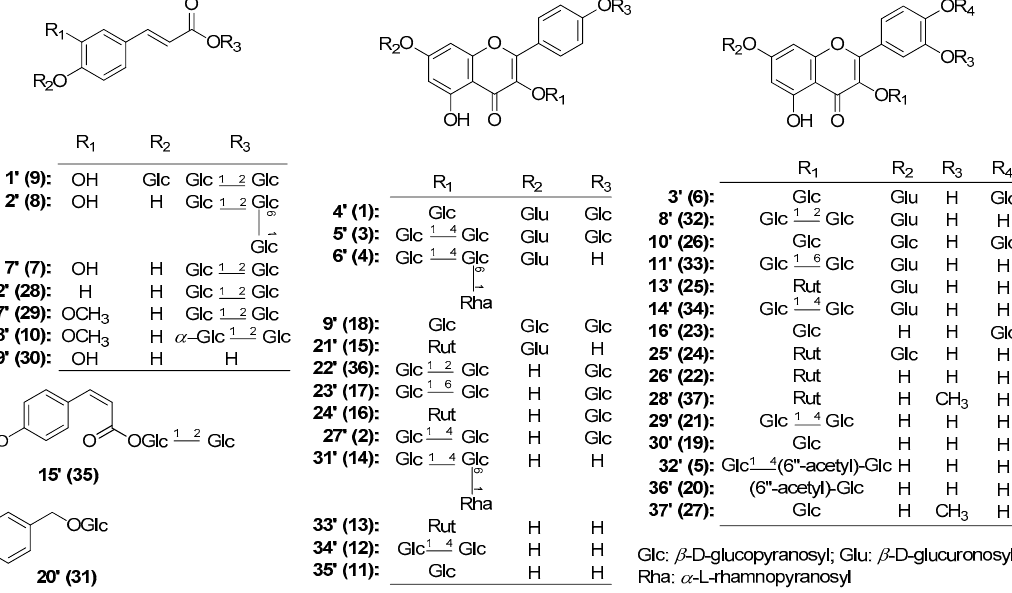
Figure 8. The structures of tentatively presumed compounds from the aerial parts of A. mongolicum .